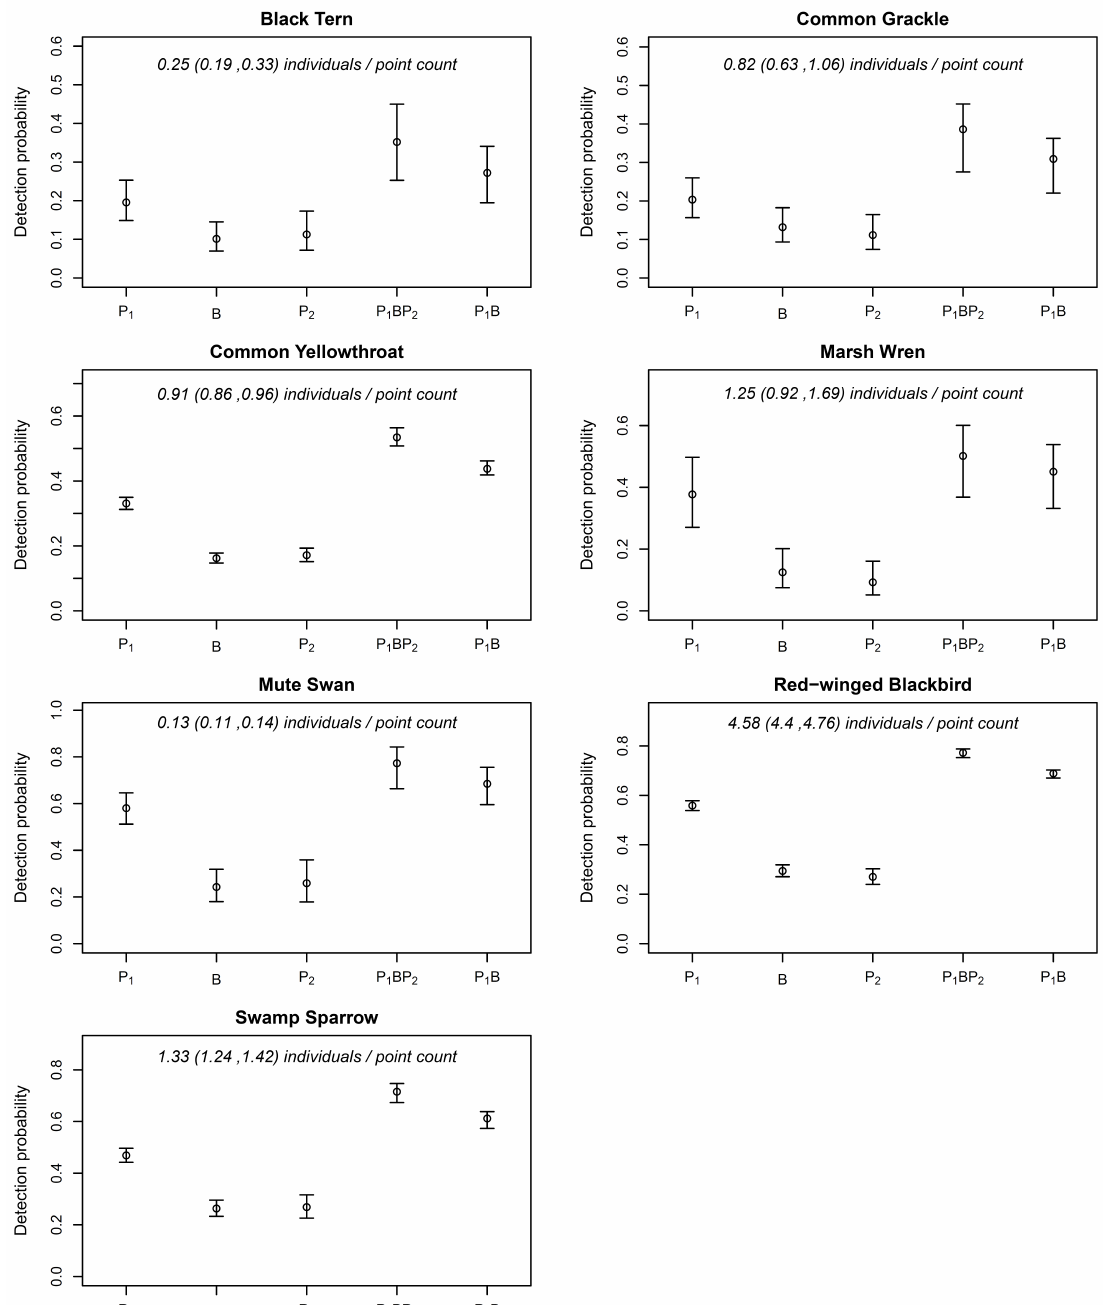
Fig. 5 . Detection probability of new individuals of some marsh breeding bird species (± 95% confidence intervals) during various 5- min periods and combinations of consecutive 5-min periods during 23,973 broadcast-assisted 15-min point counts throughout the Great Lakes–St. Lawrence region, 2008–2016. P = first 5-min passive observation period consisting of min 1–5, B = 5-min 1 broadcast period consisting of min 6–10, P = second 5-min passive observation period consisting of min 11–15, P 2 consisting of min 1–10, P BP = entire 15-min point count consisting of min 1–15. See Fig. 2 for a schematic depiction of the 1 2 periods and combinations of consecutive periods. Predicted abundance (lower, upper 95% confidence interval) from multinomial N - mixture models also shown at the top of each panel for each